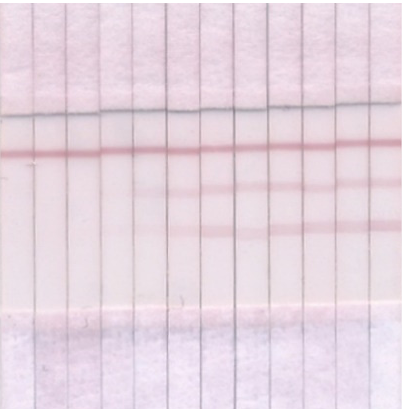
Figure 7. Images of test strips for double ICA of DA and OA. DA/OA concentrations from left to right: 2000/25, 667/8.3, 222/2.8, 74/0.9, 25/0.3, 8.2/0.1, 2.7/0.03, 0.91/0.01, 0.3/3.8 × 10 − 3 , 0.1/1.3 × 10 − 3 , 0.03/4.2 × 10 − 4 , and 0/0 ng/mL.